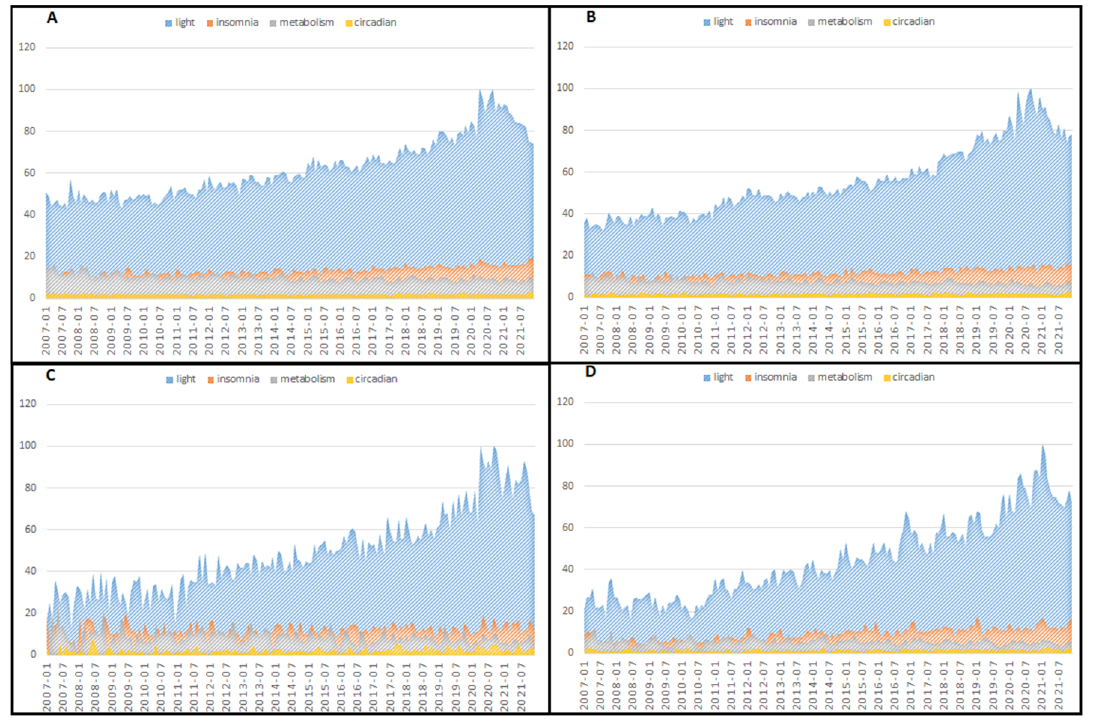
Figure 1. Variation in relative search volume associated with circadian, insomnia, light, and metabolism during each month of the study period for the entire world ( A ), the United States of America ( B ), Australia ( C ), and the United Kingdom ( D ).